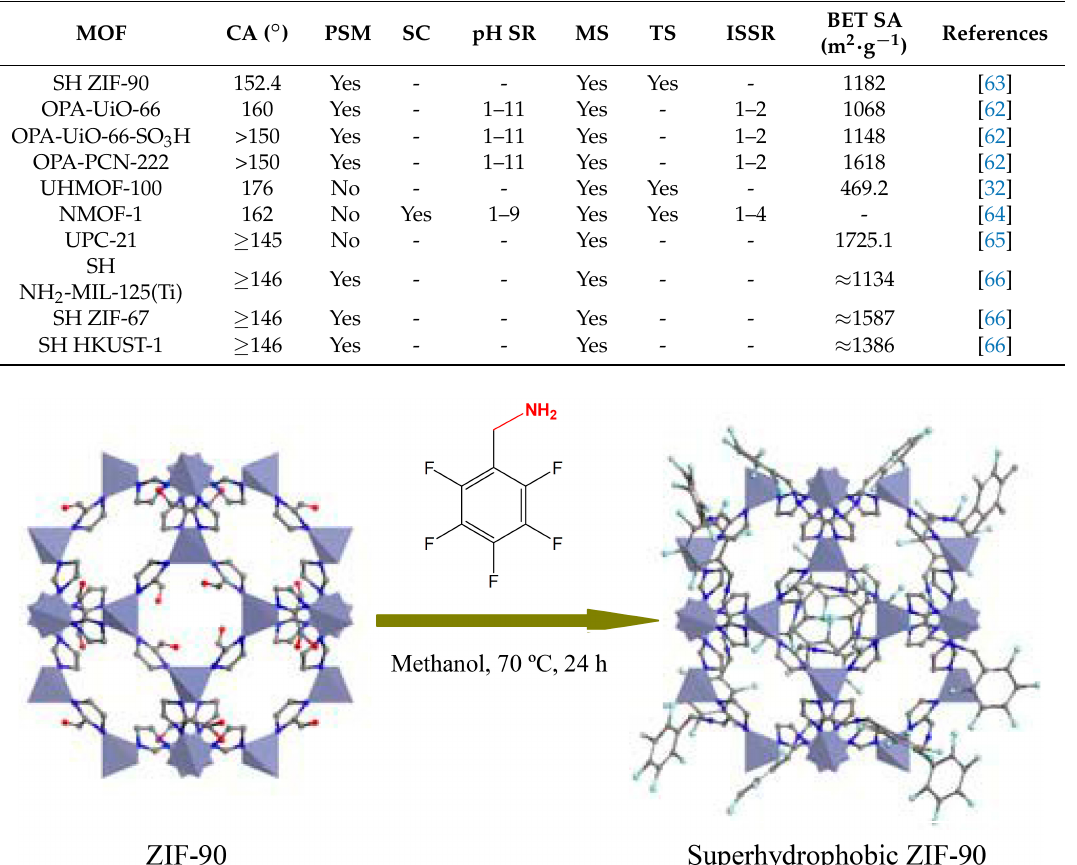
Figure 2. Scheme of the synthesis of superhydrophobic ZIF-90 via an amine condensation reaction. Reprinted with permission [63] Copyright 2016, Royal Society of Chemistry.